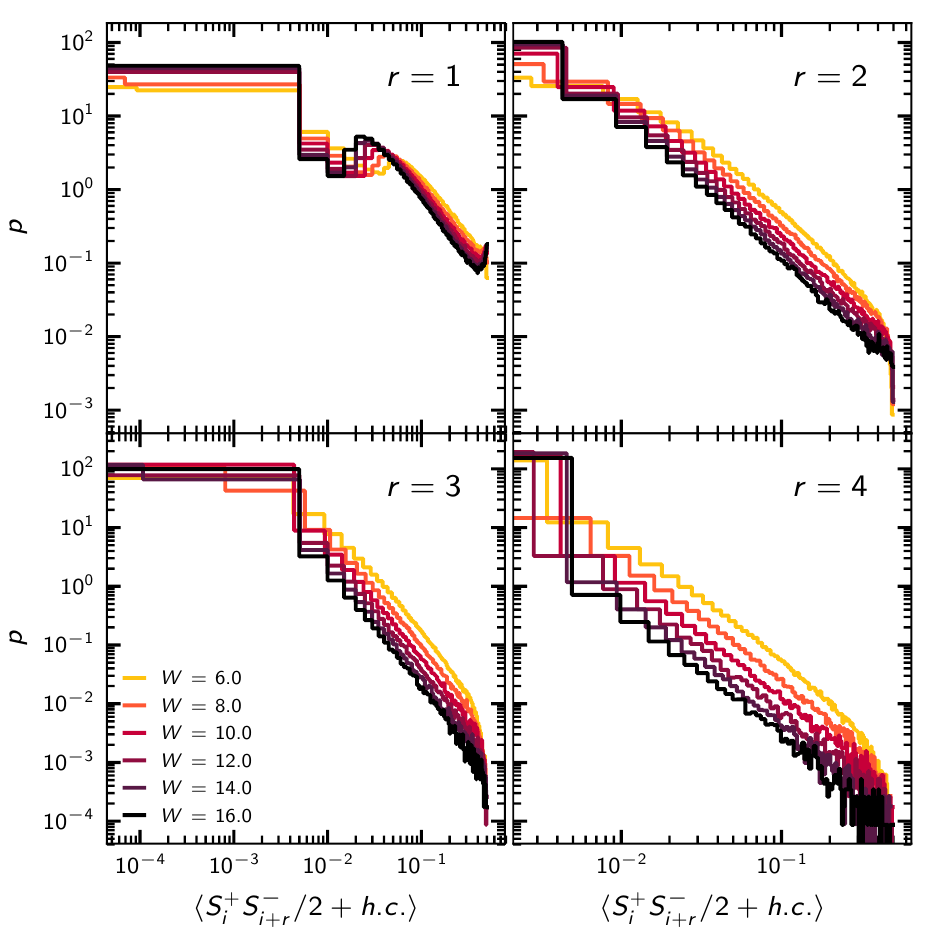
/ 2 + h . c . | n 〉 S − i + r i